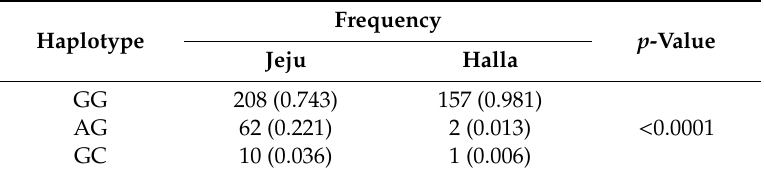
Table 3. Haplotype frequency of two PRND polymorphisms in Jeju and Halla